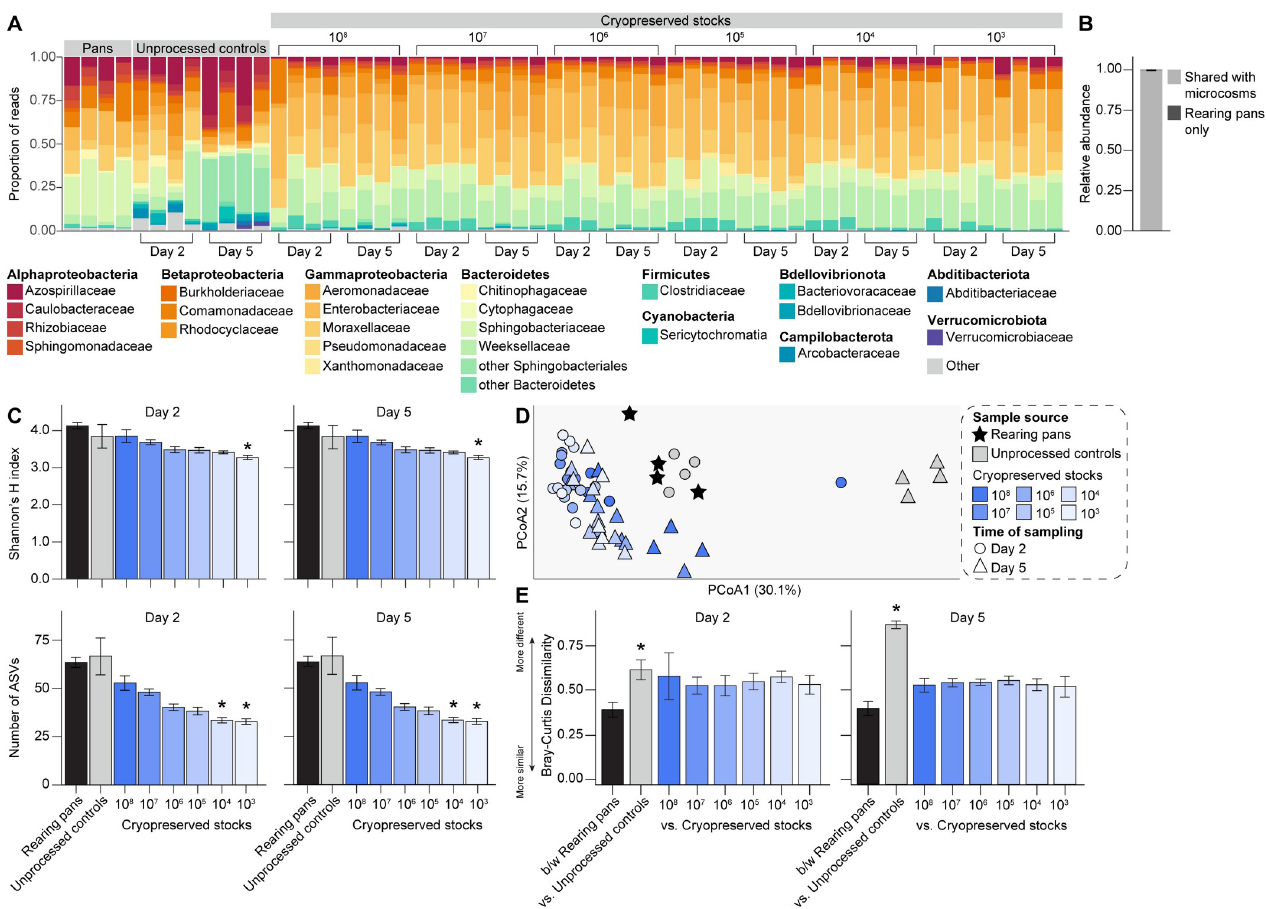
Fig 2. Bacterial diversity in laboratory larval rearing pans and experimental microcosms generated using lab-derived microbiota. (A) Relative abundance of bacterial families in water sampled from: ( i ) conventional rearing pans containing fourth instar larvae from our standard Ae . aegypti laboratory colony, ( ii ) experimental microcosms containing unprocessed water from the same rearing pans, or ( iii ) experimental microcosms containing sterile water plus material from a given cryopreserved stock. Each bar presents the proportion of sequencing reads assigned to a given bacterial family. Low abundance families ( < 1%) are represented by the ‘Other’ category. (B) Average relative abundance of rearing pan microbiota shared with experimental microcosms (mean value ± standard error is shown). (C) Alpha diversity of rearing pans and experimental microcosms, as measured by Shannon’s H index (top) and ASV richness (bottom). Mean values ± standard errors are shown. Asterisks ( * ) indicate significant differences between a given group of experimental microcosm samples relative to rearing pan samples (Dunn’s test with Bonferroni correction, P < 0.01). (D) Principal coordinates analysis using the Bray-Curtis dissimilarity index. Symbols are colored by sample source (rearing pans, black; experimental microcosms containing unprocessed water, grey; experimental microcosms containing sterile water plus material from a given cryopreserved stock, blue). Time of sampling (Day 2 or Day 5) of experimental microcosms is designated by symbol shape. (E) Average Bray-Curtis dissimilarity between (b/w) rearing pans versus between a given rearing pan and group of experimental microcosm samples. Mean values ± standard errors are shown. Asterisks ( * ) indicate comparisons for which the average dissimilarity between a given rearing pan and group of experimental microcosm samples was significantly higher than that expected as a result of the microbiota isolation and cryopreservation procedure itself ( i . e ., between rearing pans) (Dunn’s test with Bonferroni correction, P < 0.05).